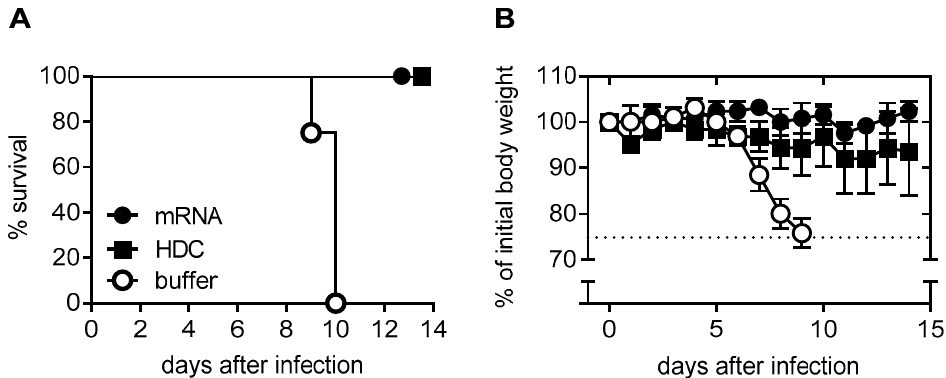
Figure 1. Protective capacity of mRNA vaccine against lethal intracerebral (i.c.) rabies challenge infection in mice (adapted from reference [31]). ( A ) shows the survival curve of three groups of female BALB / c mice ( n = 5 per group) who received two doses of 80 µ g RABV-G mRNA, 0.1 human dose of human diploid cell rabies vaccine (HDC), or injection bu ff er 21 days apart. Six weeks later, they were infected i.c. with rabies virus. ( B ) shows the mean body weight ( ± SD) of challenged animals. Animals were euthanized if they lost 25% of body weight.